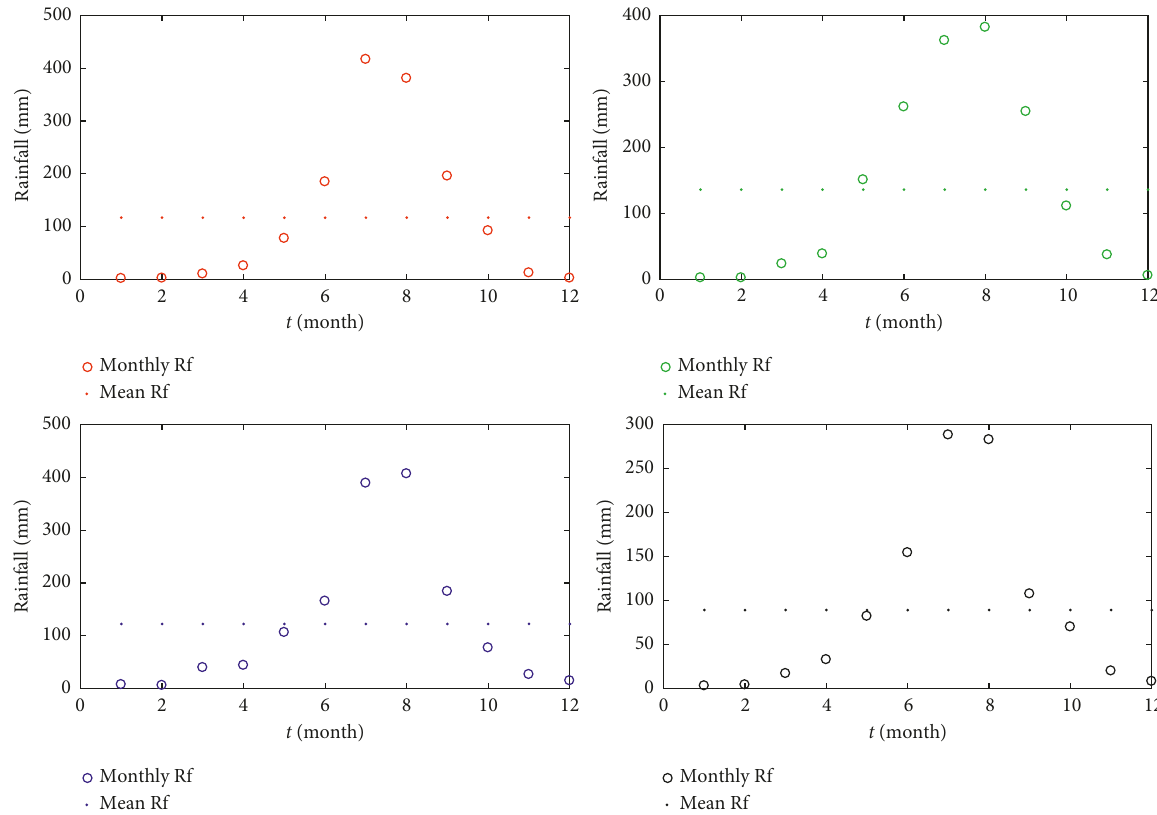
Figure 2: The monthly precipitation (mm) averaged over 1985–2015 for the four stations: (a) Bahir Dar, (b) Dangila, (c) Debre Tabor, and (d) Gondar. Circular points show climatic mean, and horizontal dotted lines show annual